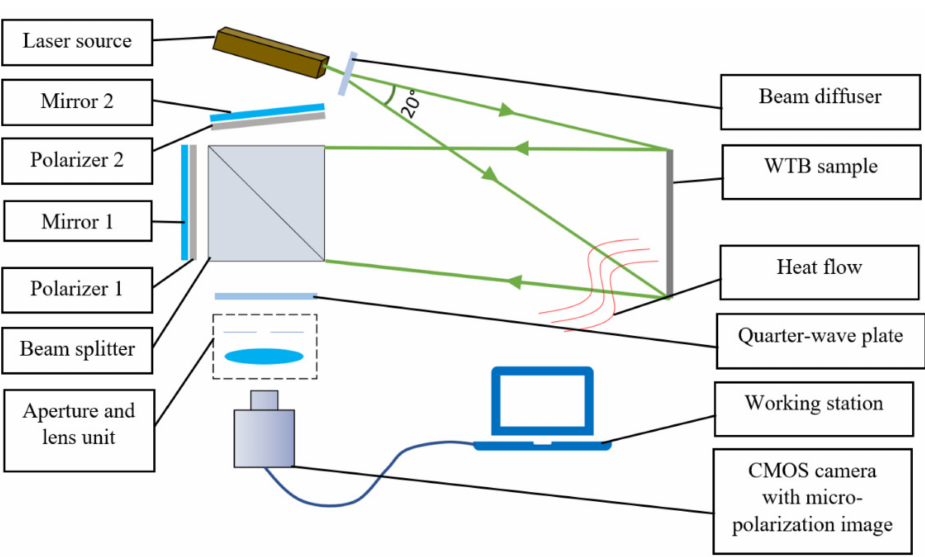
Figure 1. Pixelated spatial phase shift shearography system setup for dynamic WTB inspection.